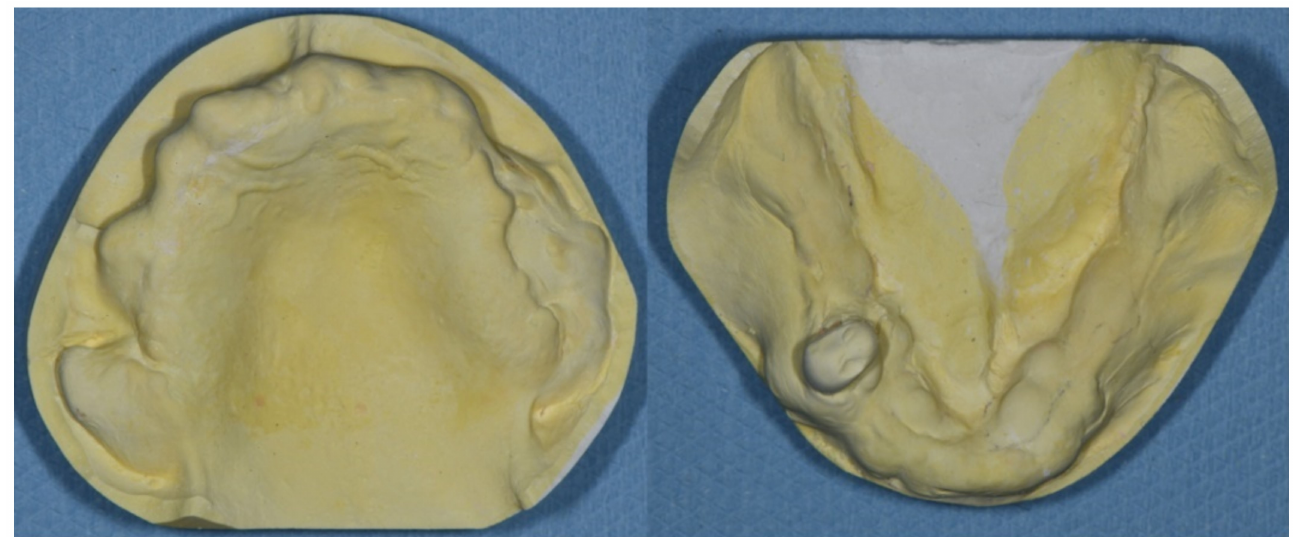
Figure 2. ( Left ). The maxillary study model. The bony exostoses around bilateral tuberosity areas hindered the proper extension and the peripheral seal of the maxillary denture. ( Right ) The mandibu- lar study model. The lingual bony exostoses extended from the lingual frenum to the bilateral retromylohyoid fossa